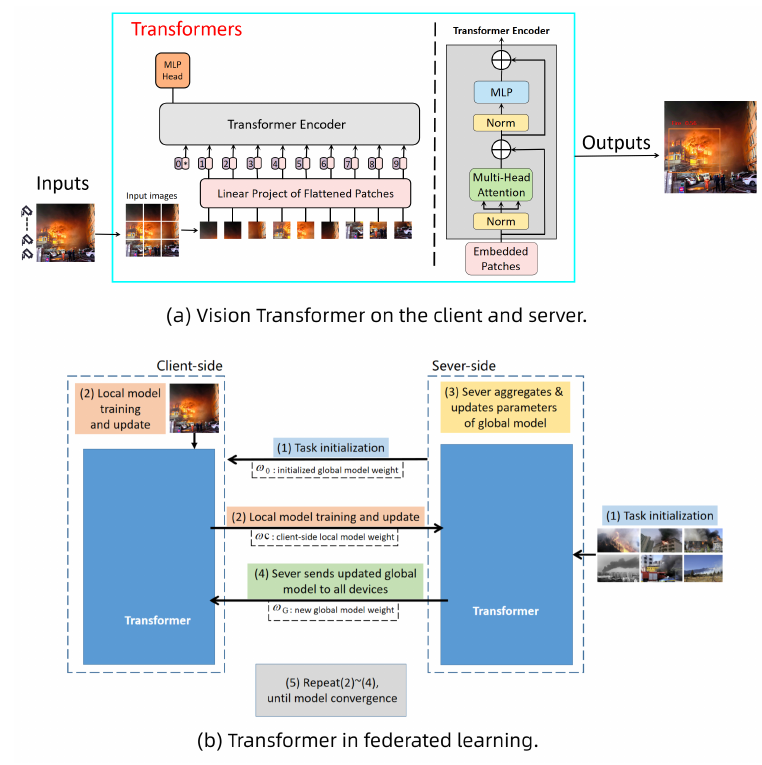
Figure 2. Vision Transformer in Federated Learning. Figure ( a ) is the general workflow of Vision Transformer on the client and server. In figure ( b ), the steps of the transformer in federated learning are